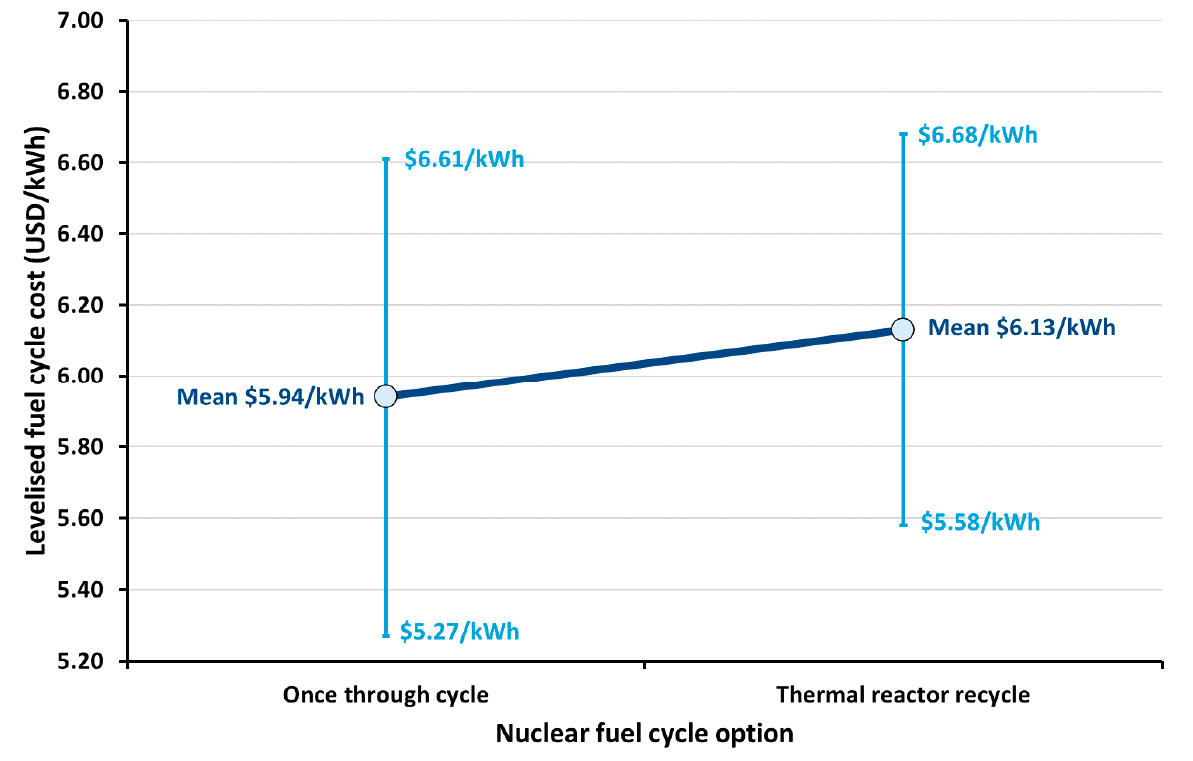
Figure 8. Comparison of LFCC of the OTC and TTC (TRR—thermal reactor recycle scenarios) from Zhou et al. [37].